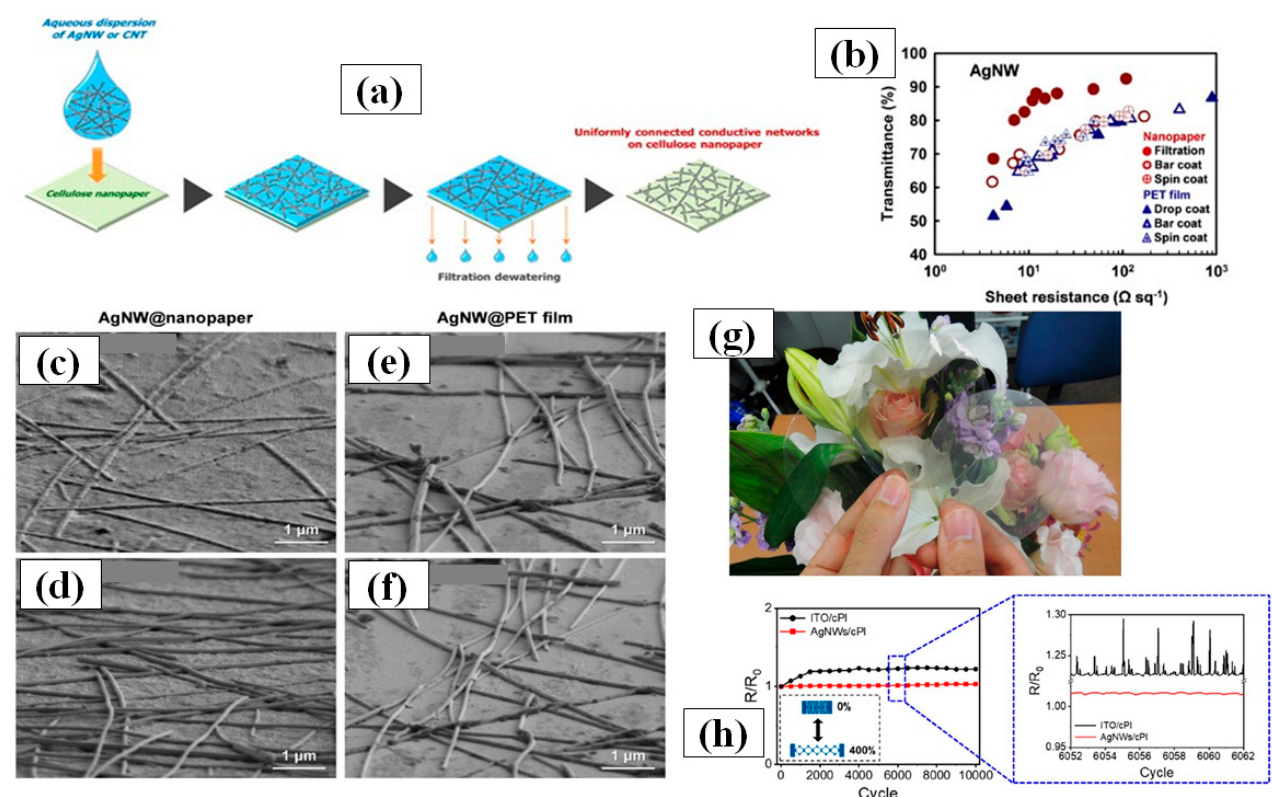
Figure 11. ( a ) Putative process of the formation of AgNW on nanopaper by drop and filtration coating, ( b ) A comparison between of optoelectronic properties of fabricated TCE between various methods. AgNW@nanopapers prepared by ( c ) filtration coatin and ( d ) bar coating and AgNW@PET films prepared by ( e ) drop coating and ( f ) bar coating ( g ) Optical images of original nanopaper (left), CNT@nanopaper (middle) and AgNW@nanopaper (right). Paper size: 75mm in diameter. (adapted from [166] with permission from Springer Nature, 2014) ( h ) R/R 0 vs no. of cycles with 0 to 400% strain each time of ITO/cPI and AgNW/cPI (adapted from [118] with permission from ACS publications,